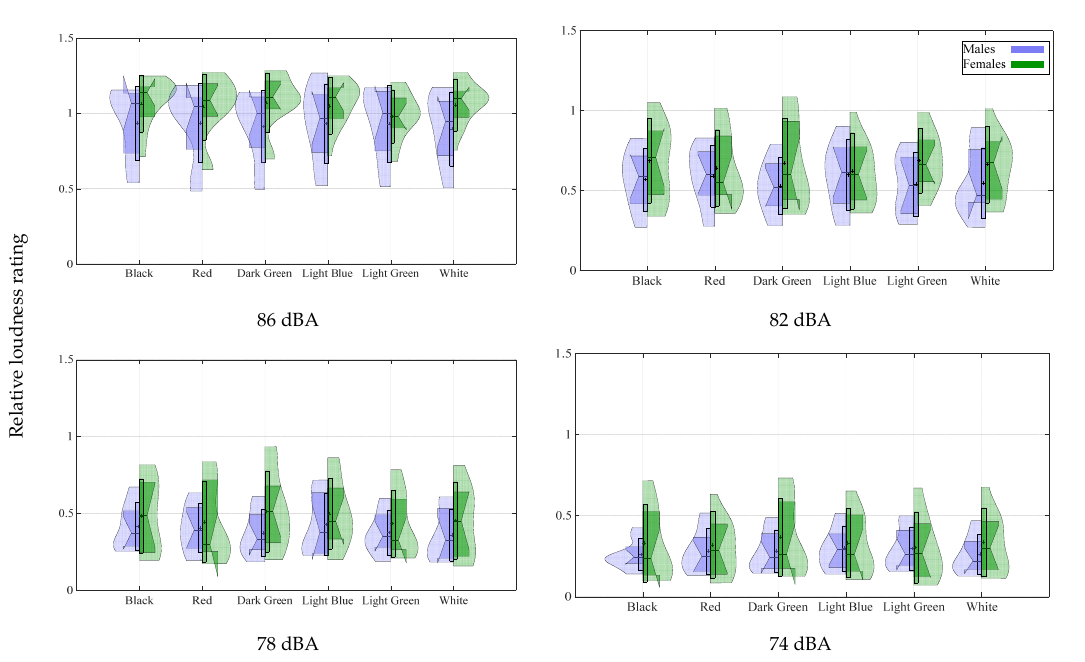
Figure 2. Relative loudness ratings (ref: black color 86dBA results), grouped by level and presented per color of the visual stimuli. Boxplots (median: horizontal black line, lower limit: first quartile, upper limit: third quartile, notch inf.: median − 1.57 × IQR/sqrt(n), notch sup: median + 1.57 × IQR/sqrt(n)), violin plots (upper limit: 99th percentile, lower limit: 1st percentile), mean: cross, upper, and lower limits: standard deviation.